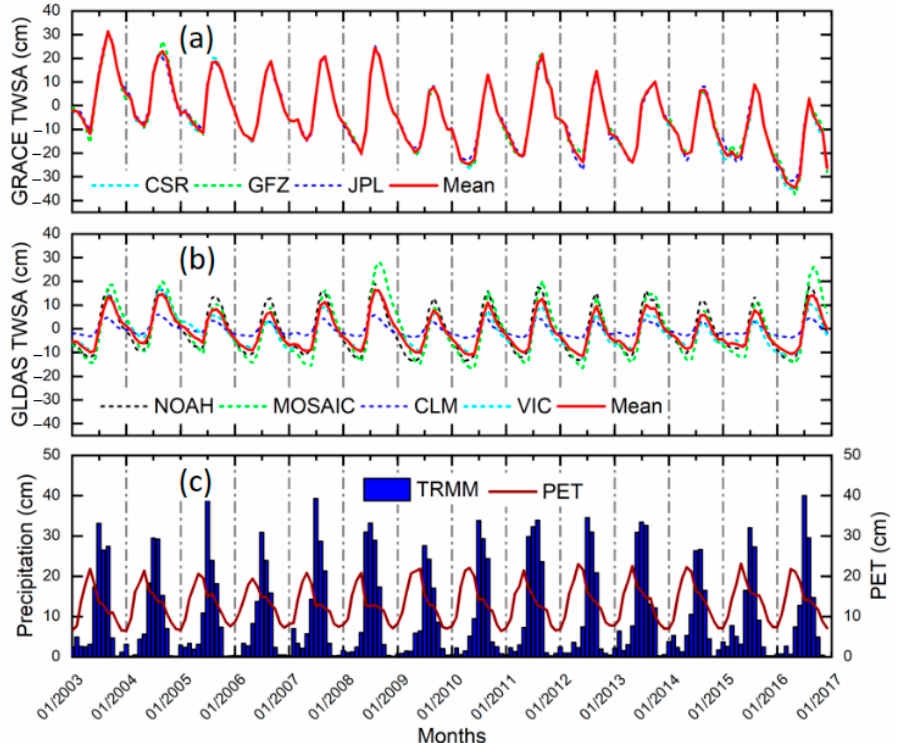
Figure 2. Mean monthly values of ( a ) GRACE terrestrial water storage anomaly (TWSA) data (derived from three agen- cies), ( b ) GLDAS data (derived from four models), and ( c ) Tropical Rainfall Measuring Mission (TRMM) and potential evapotranspiration (PET) precipitation data averaged for the basin for the period from 2003 to 2016.